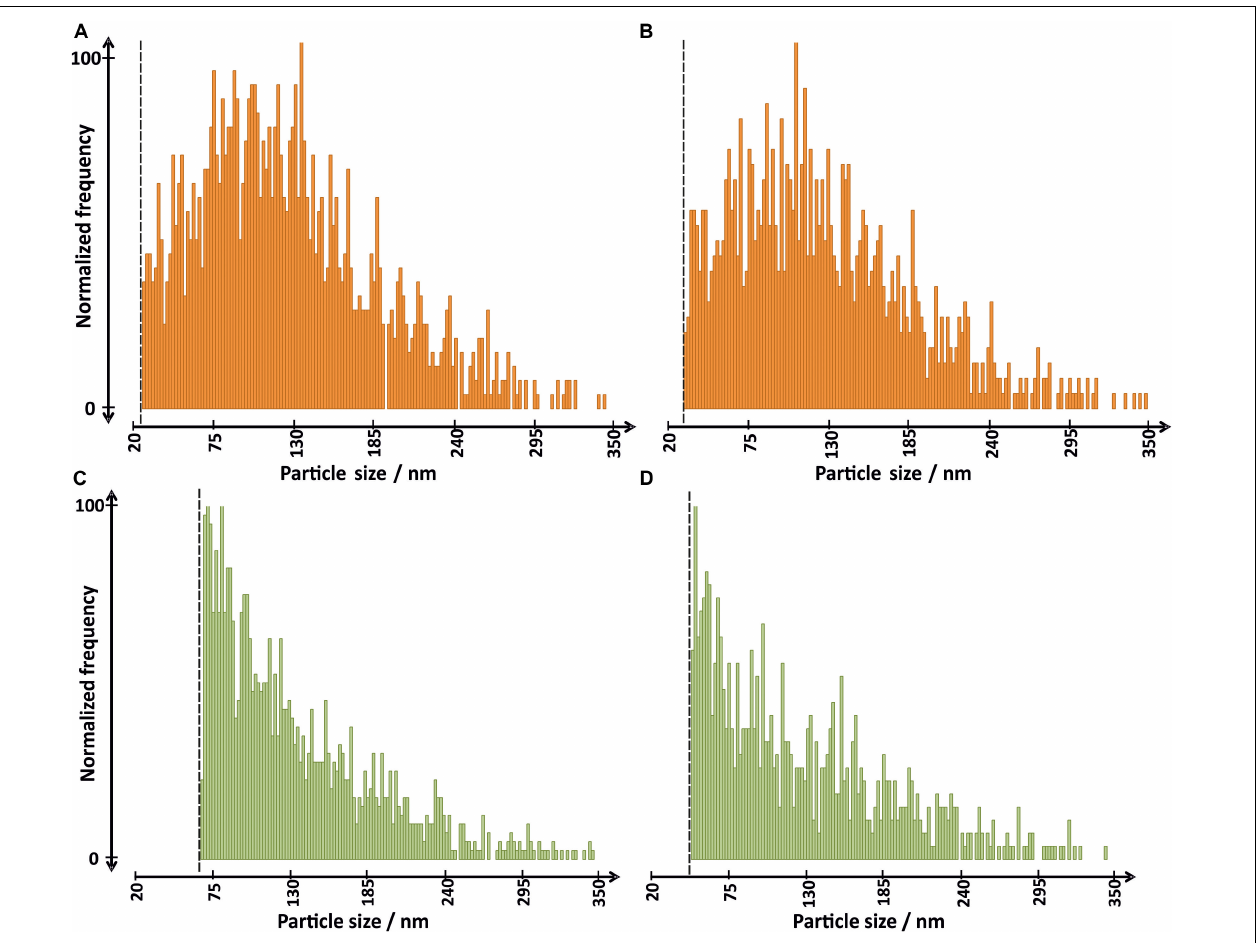
FIGURE 4 | Size distributions obtained by SP-ICP-MS for (A) roots of plants treated with TiO 2 NP suspension A, (C) leaves plus stems of plants treated with TiO 2 NP suspension A, (B) roots of plants treated with TiO 2 NP suspension B, and (D) leaves plus stems of plants treated with TiO 2 NP suspension B. Vertical lines represent the size limit of detection for each